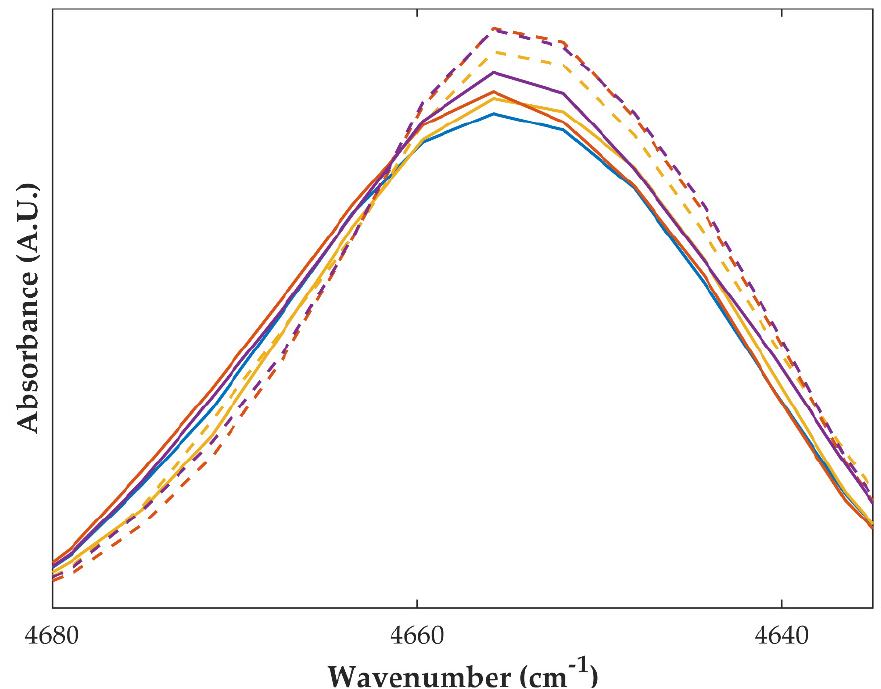
Figure 6. Fourier-transformed near infrared spectra of partially amorphous olanzapine in a physical mixture (blue) and granules (10%, yellow, 25%, orange, or 40%, purple, of water for granulation) dried at 40 °C (solid line) and 90 °C (dashed line).